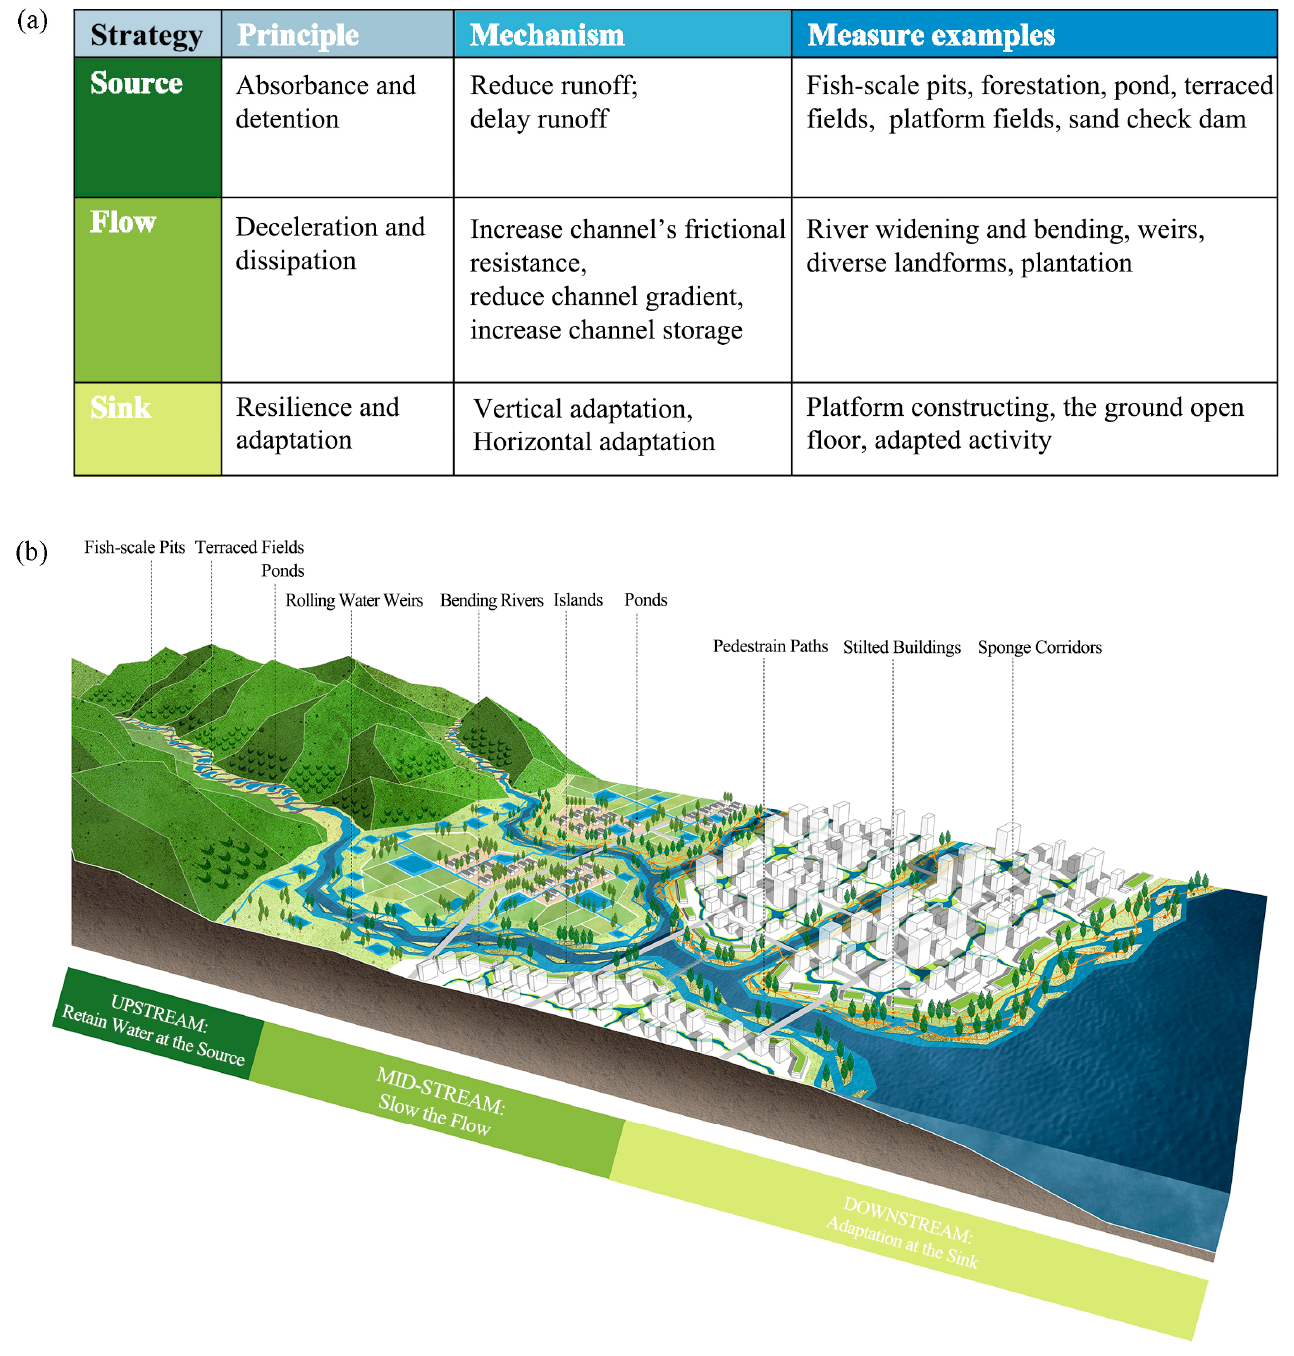
Figure 1. Conceptual framework of the Sponge Watershed Approach for a flood-resilient city. ( a ) Strategy and example intervention measures of the source, flow, and sink components. ( b ) Diagram of these example measures distributed from the mountain to the sea.